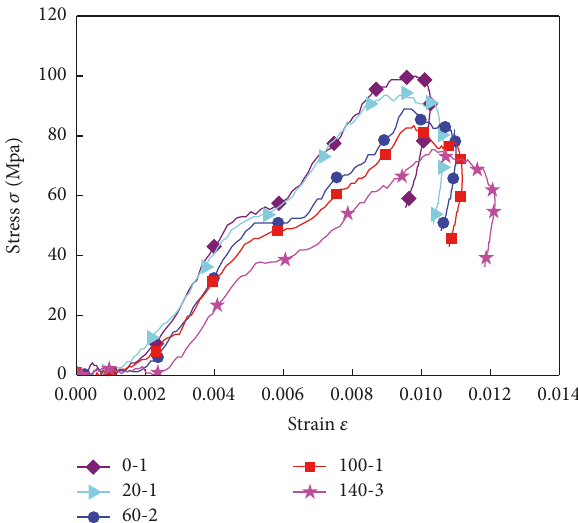
Figure 9: Relationship between energy absorption and number of freeze-thaw